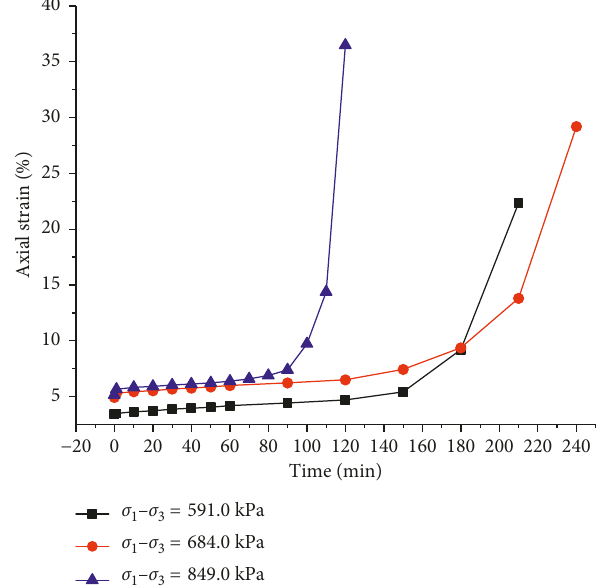
Figure 3: Relation between creep strain and time under different confining pressures.